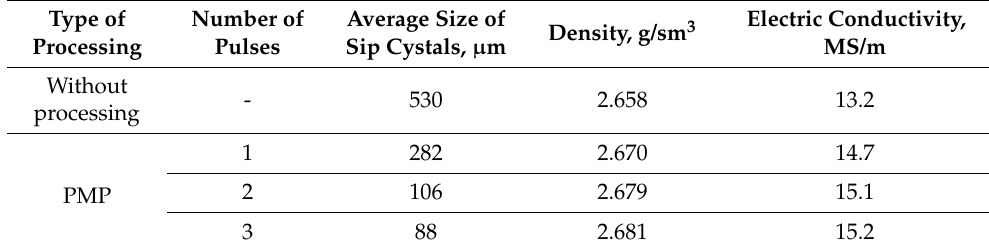
Table 5. Influence of PMP parameters on structure and properties of hardeners Al-20%Si